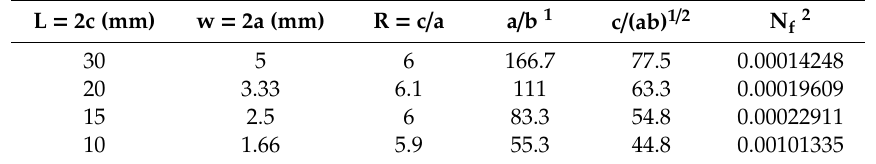
1 2 b = 30 µ m, thickness of the ribbon of Metglas ® 2826MB3; 2 Fluxmetric demagnetizing factor value,